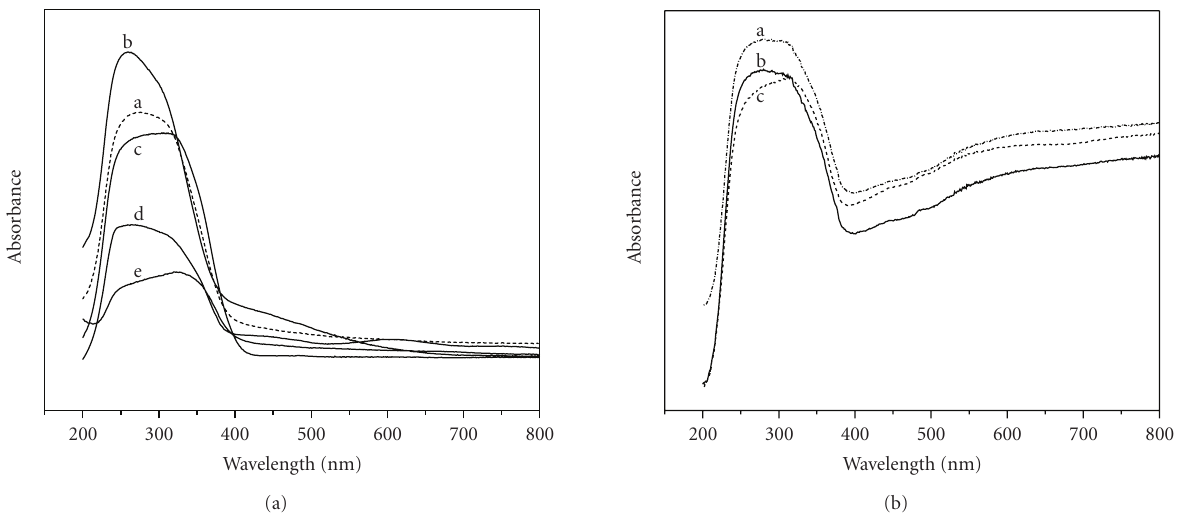
Figure 6: Di ff use reflectance UV-Vis spectra of (a) hydrothermally prepared Au/TiO 2 and TiO 2 samples: (a) H2, (b) H3, (c) H4, (d) H6, and (e) T1, and (b) impregnation-prepared Au/TiO 2 samples: (a) I1, (b) I2, and (c) I3.